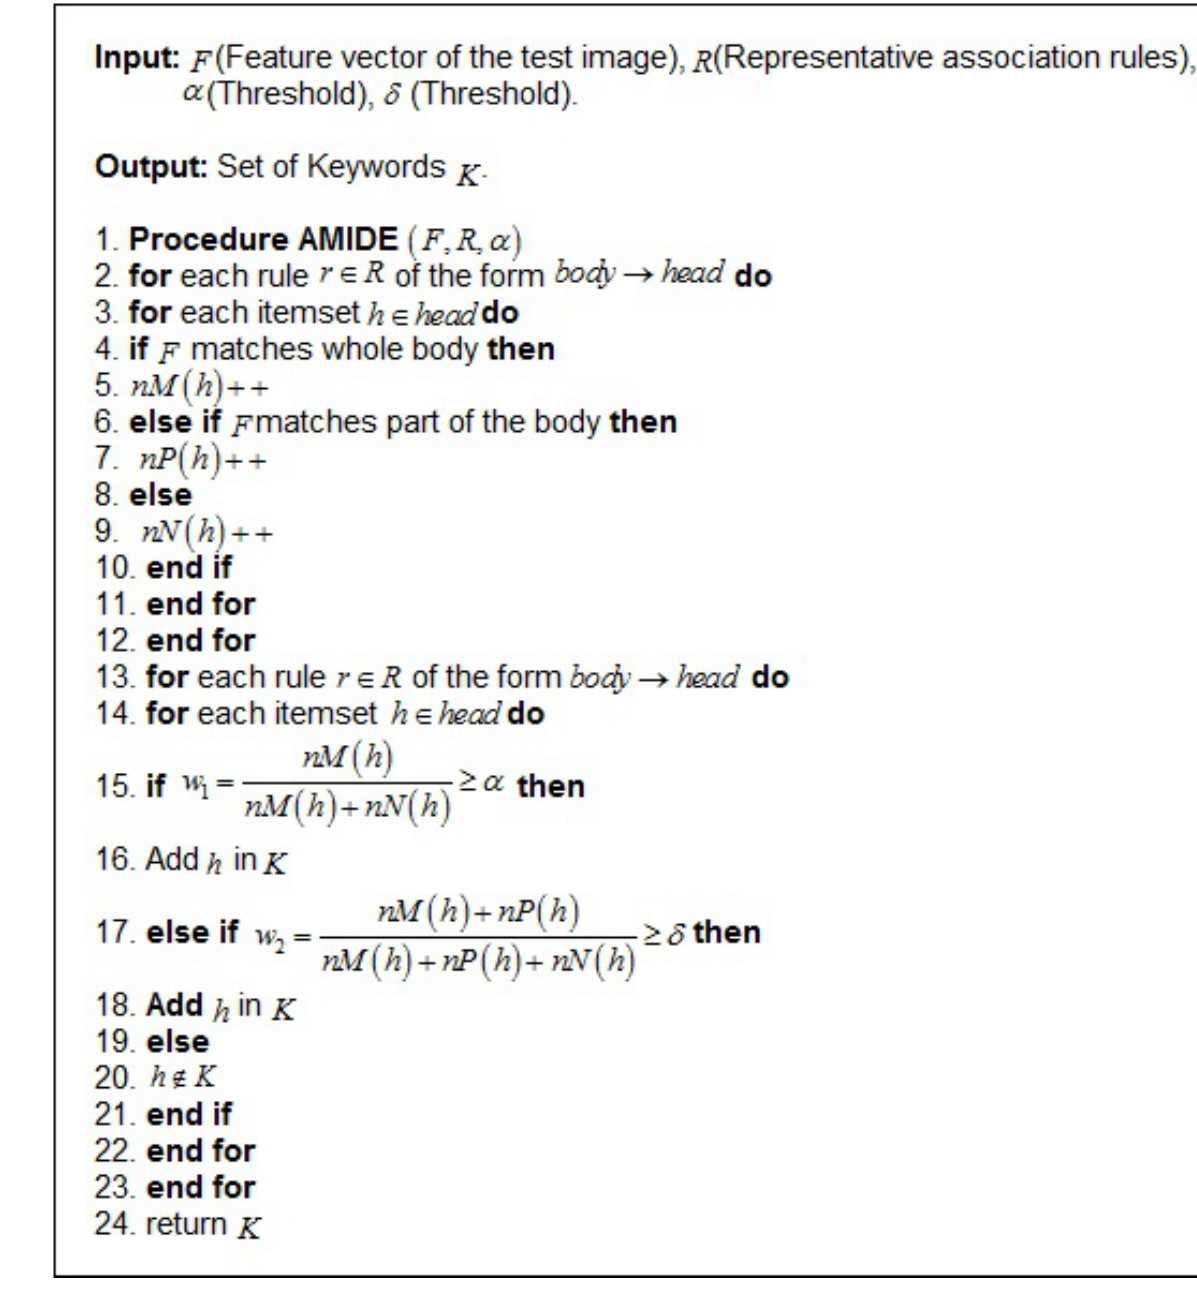
The dataset mini-MIAS [61] used in our experiments is taken from the mini-Mammographic Image Analysis Society (mini-MIAS). It consists of 322 images and belongs to three big categories: normal, benign and malignant. There are